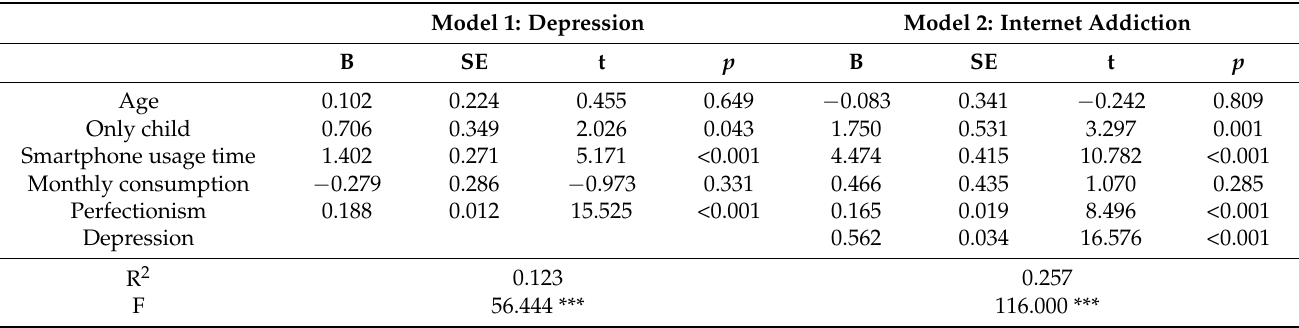
Table 4. Result of mediation